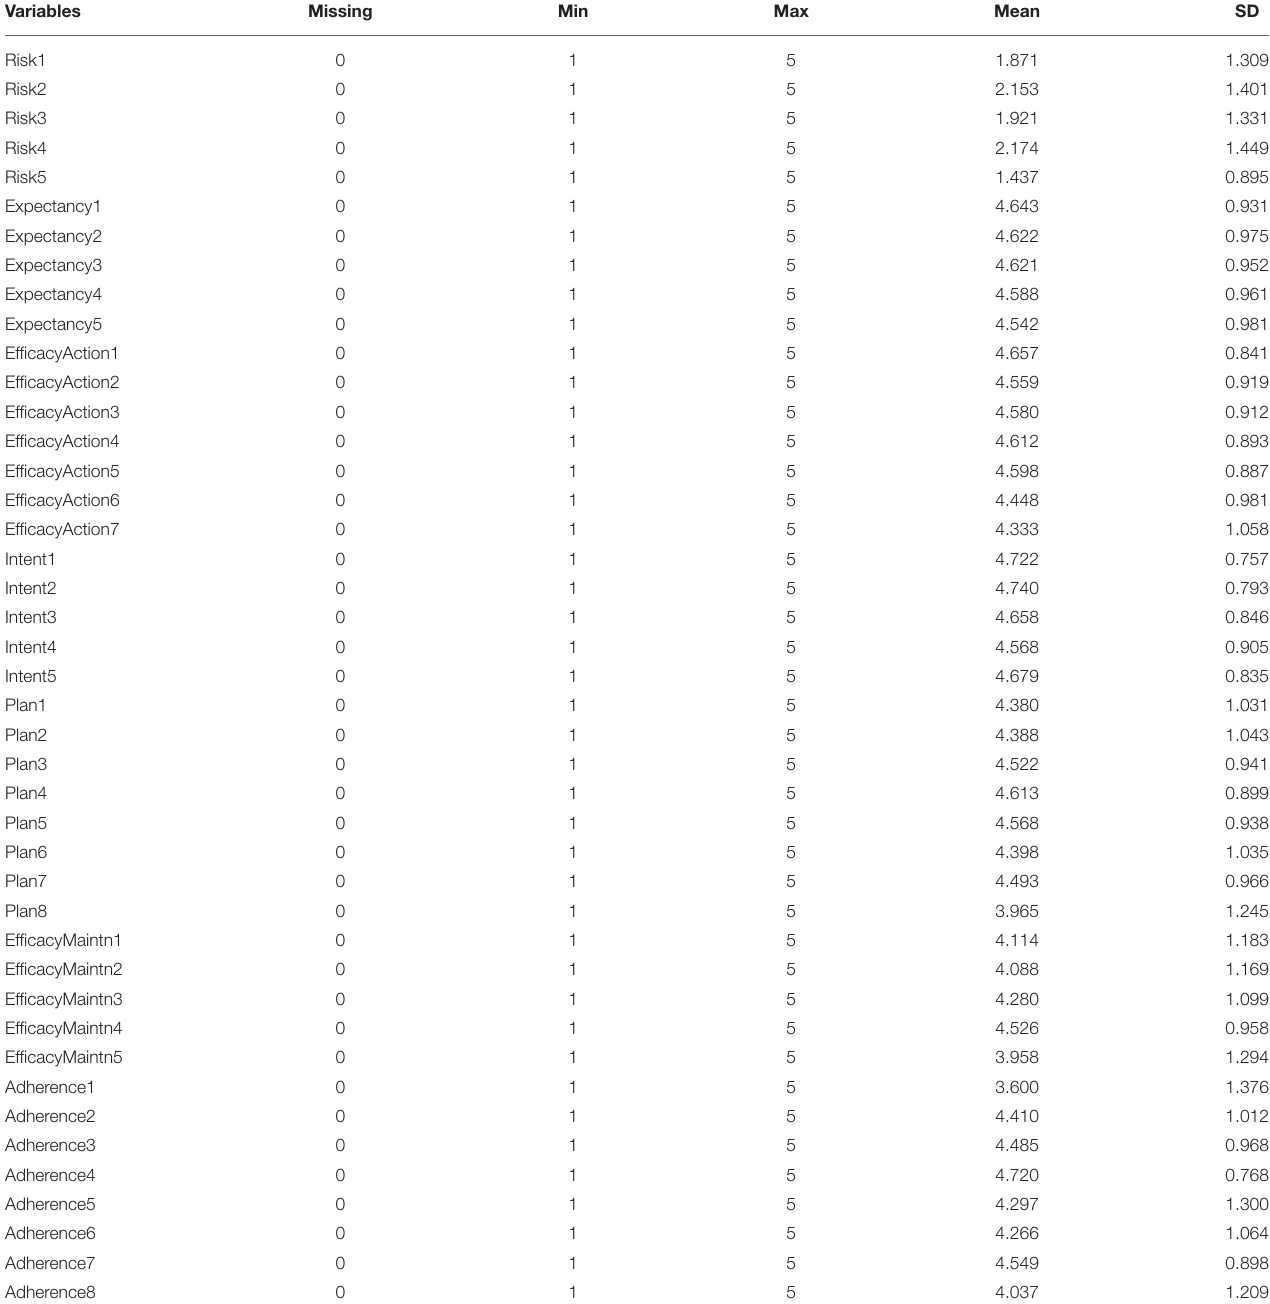
TABLE 2 | Research variables and measurement